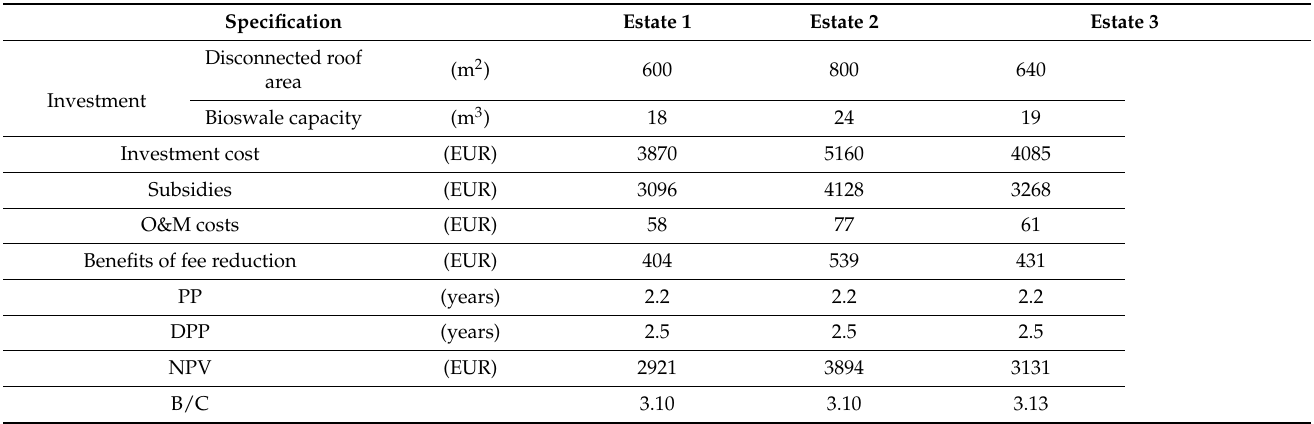
Table 17. Evaluation of the profitability for disconnecting 20% of the roof area including co-financing offered in